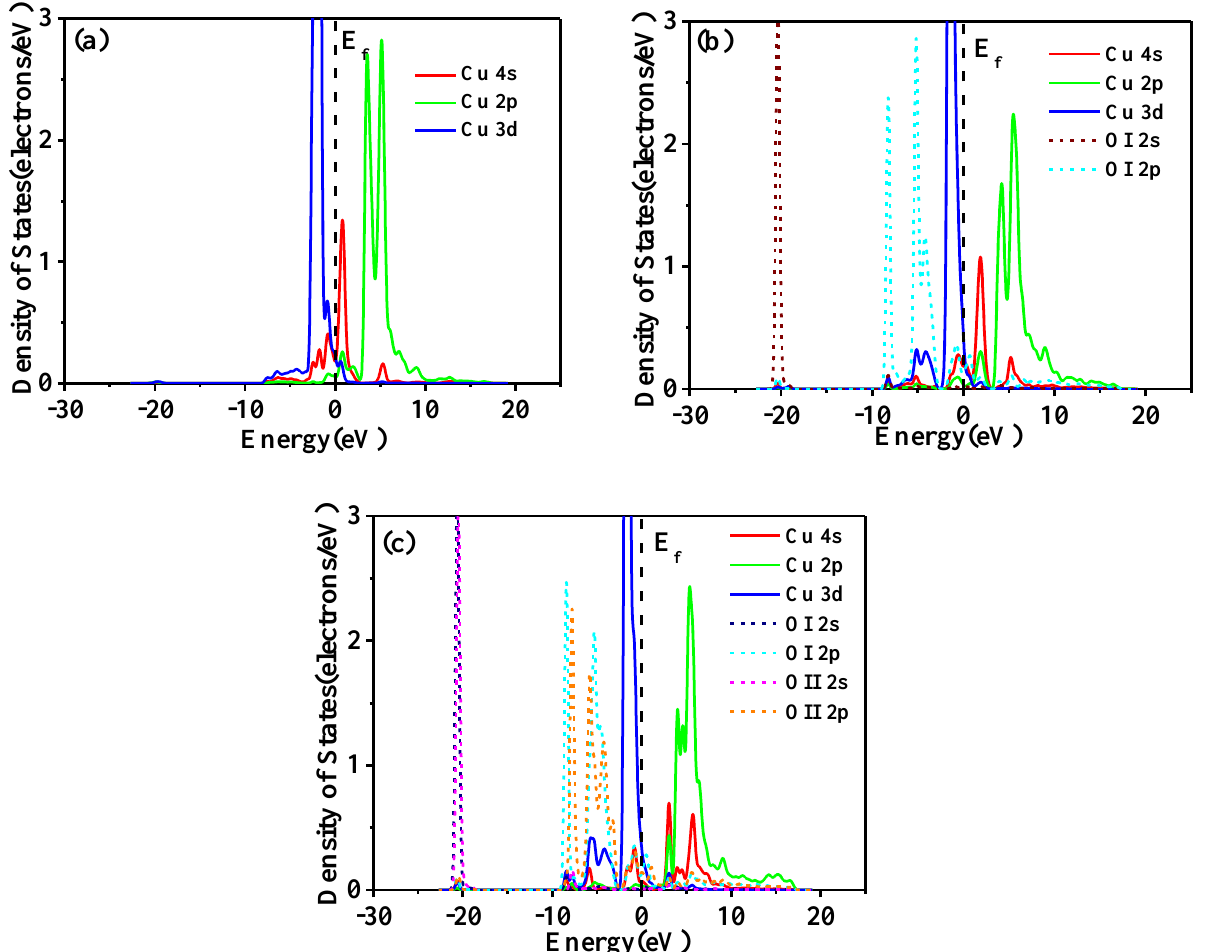
Figure 5. Partial density of states (PDOS) of different atoms of adsorbates: ( a ) Cu 2+ , ( b ) Cu(OH) + , ( c ) Cu(OH) 2 . When Cu(OH) + adsorbed on the specularite (0 0 1) surface (Figure 5b), the PDOS of the Cu 4s orbital peak near the Fermi level became weaker and shifted to the right, and the PDOS of Cu 4s orbital at 1.96 eV overlapped with that of the OI atom of Cu(OH) + . Combined with the PDOS of O1 atom on the specularite surface (Figure 4c), it was found that the 4s orbital of the Cu atom overlapped with the 2s orbital of O atom on the specularite surface, indicating that the Cu atom of Cu(OH) + may have interacted with the O atoms on the specularite surface. At the same time, by comparing the PDOS of OI atoms of Cu (OH) + with that of Fe1 atoms on the surface of specularite (Figures 3c and 5b), it can be seen that the new peaks appeared at − 20 eV, which attributed to the Fe 4s and 3d orbital and overlapped with the OI 2p orbital, indicating that the OI atoms of Cu(OH) + interacted with the Fe atoms on the surface of the specularite, which further confirmed that the ap- pearance of new 4s orbital peaks of Fe atoms on the surface of specularite at –20 eV was caused by the adsorption of Cu(OH) + .